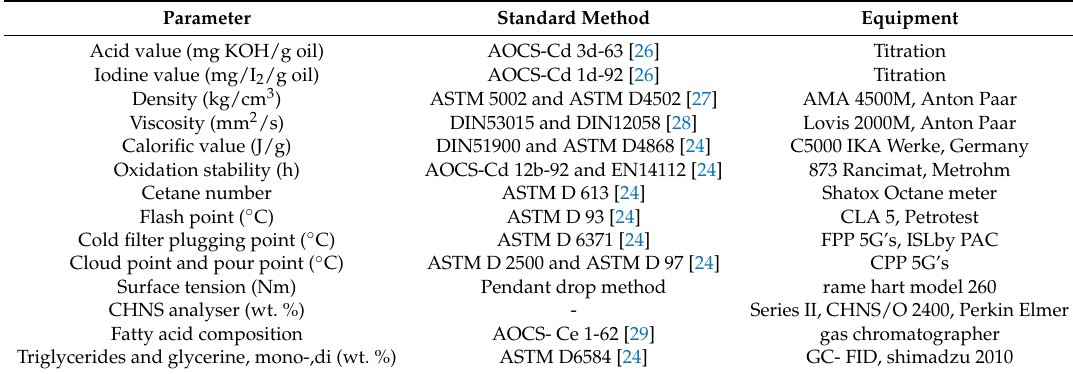
Table 1. List of equipment’s used and their standard